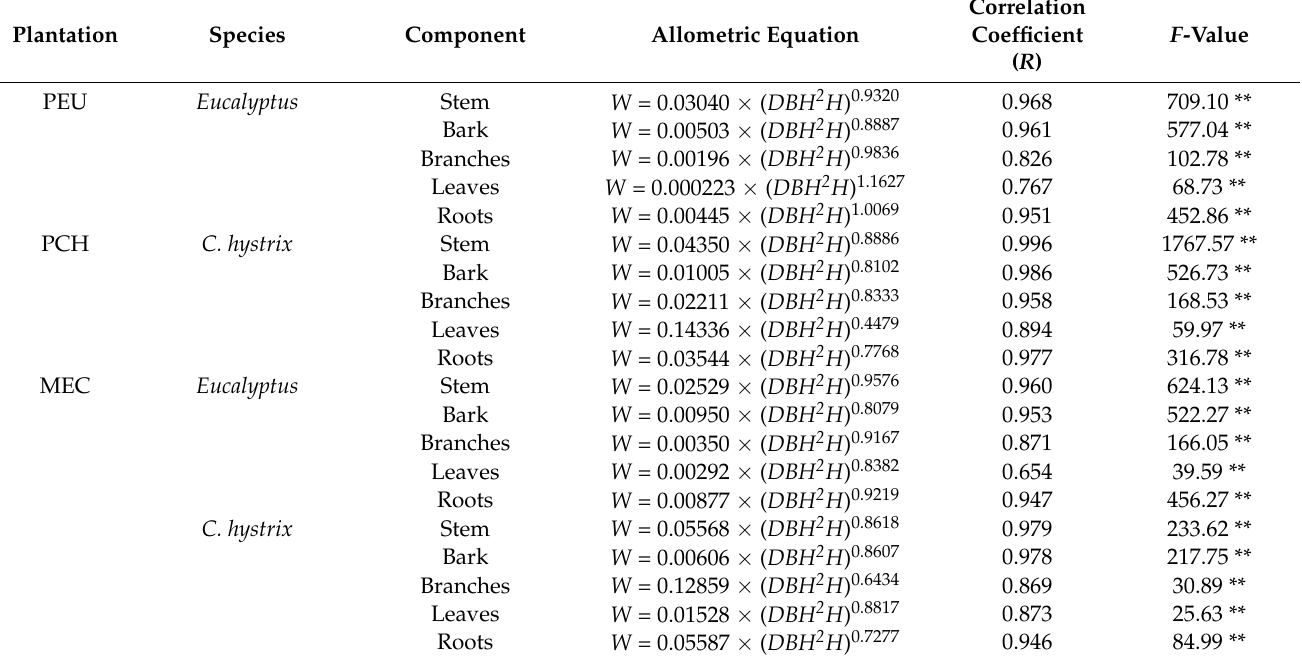
For PEU, n = 50; for PCH, n = 17; for MEC: eucalypt, n = 55 and C. hystrix , n = 12. ** p < 0.01. Four quadrants of understory vegetation (each 5 m × 5 m) and litter (each 1 m × 1